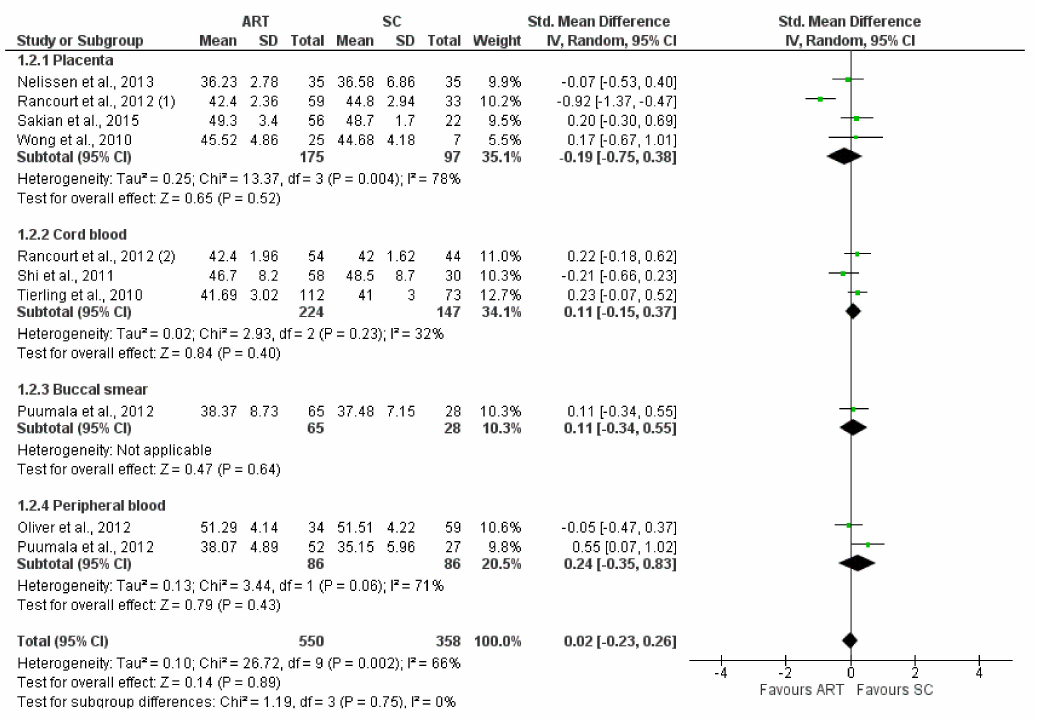
Figure 2. Methylation levels of H19 CTCF3 [25,33,52,58,65]. ART, assisted reproductive technique; SC, spontaneous conception.